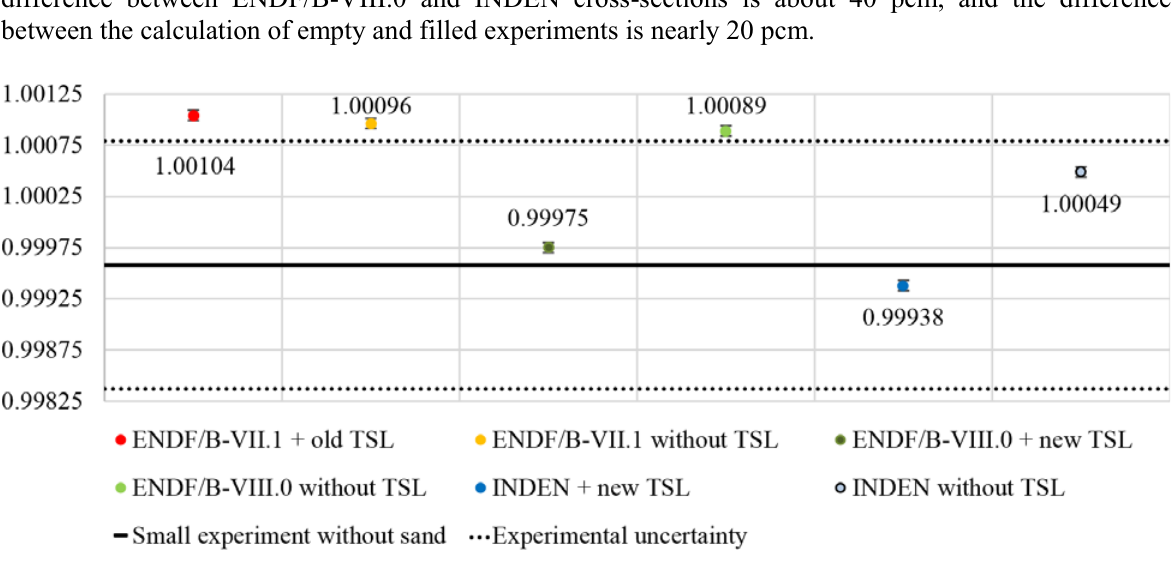
Figure 3. Multiplication factor for small experiment with silicon in different nuclear data